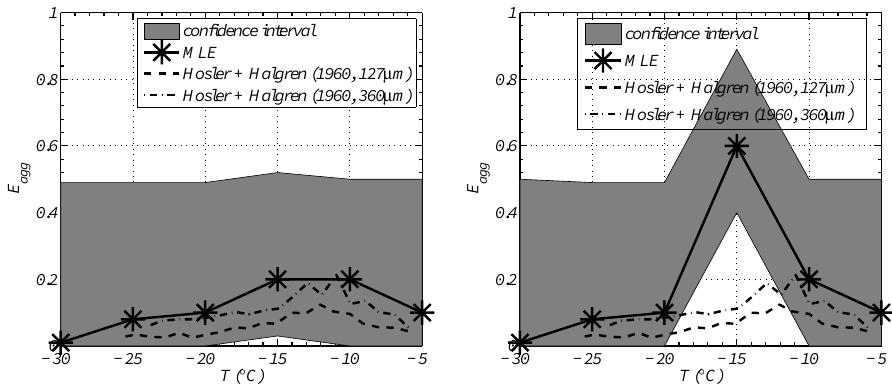
Fig. 14. Our estimates (MLE – maximum likelihood estimate) of the aggregation efficiency vs. temperature, with the results of Hosler and Halgren also shown. Panel (a) shows our estimate using a low value of the inherent growth ratio; (b) shows our estimate when using a higher value of the inherent growth ratio, which gives better agreement with the number of monomers in each size range (Fig. 16).